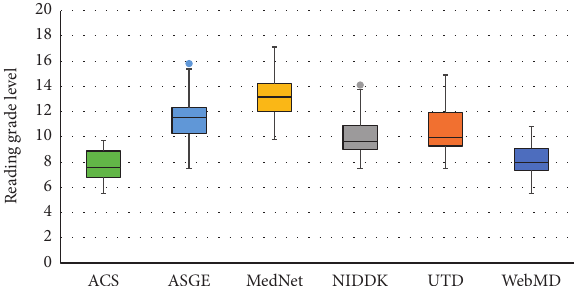
Figure 3: Box and whisker plot analysis of the reading material pertaining to colonoscopies. The American Cancer Society (ACS) had a median of 7.6 (5.5–9.7). The American Society for Gastrointestinal Endoscopy (ASGE) had a median of 10.3 (7.5–15.8), Medicine.Net (MedNet) had a median of 12.0 (9.8–17.1), the National Institute of Diabetes and Digestive and Kidney Diseases (NIDDK) scored a median of 9.6 (7.5–14.1), UpToDate Beyond the Basics (UTD) had scored a median of 10.0 (7.5–14.9), and finally, WebMD had a median of 8.0 (5.5–10.8).